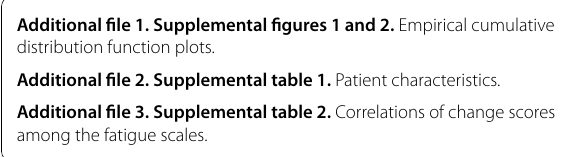
MBSR Mindfulness-based stress reduction. BEAT Cancer trial Better Exercise = = Adherence after Treatment for Cancer trial. FSI Fatigue Symptom Inventory. = AUC is the probability of correctly discriminating between survivors who reported significant fatigue based on the SF-36 Vitality score 45 and those who ≤ did not at baseline. SE Standard =